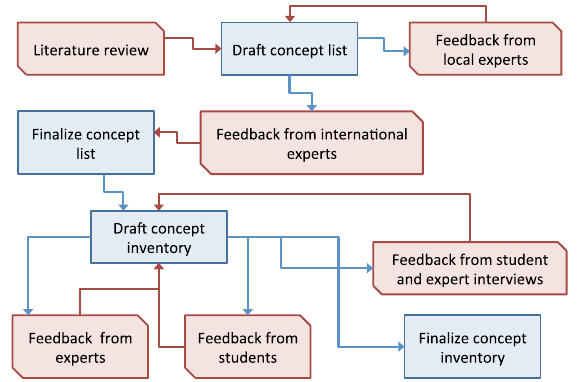
1. The process for developing an Action Concept In- ventory, showing feedback. Blue rectangular boxes represent creative processes while red truncated-corner boxes represent feedback and